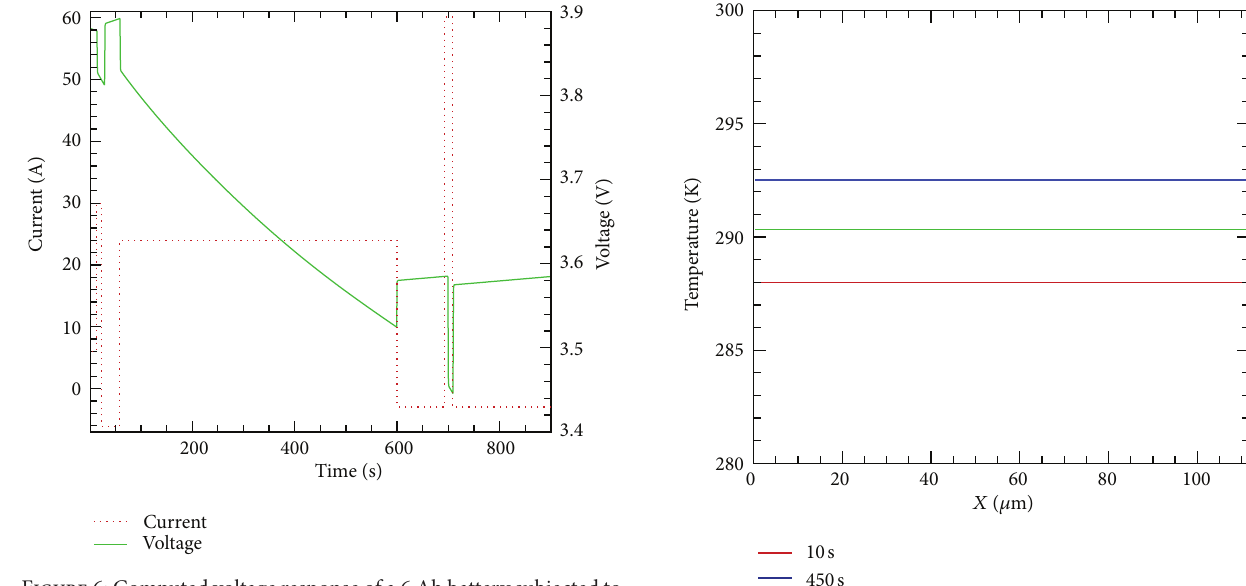
Figure 6: Computed voltage response of a 6 Ah battery subjected to an arbitrary load (current) over a 15-minute period. The prescribed load (current) is shown by the dotted red line, while the predicted voltage is shown by the solid green line. Positive current denotes discharge.